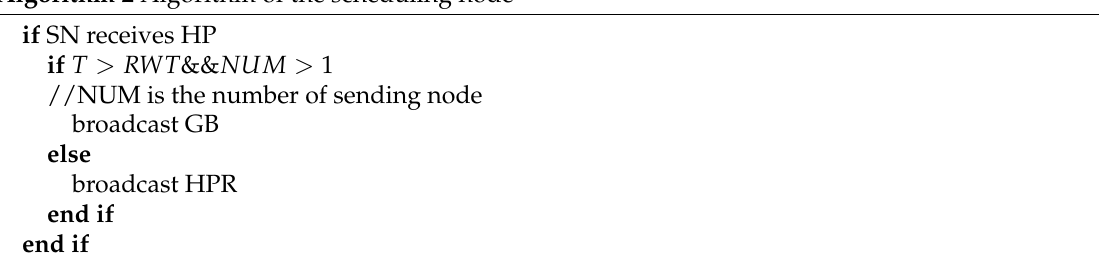
Algorithm 2 Algorithm of the scheduling